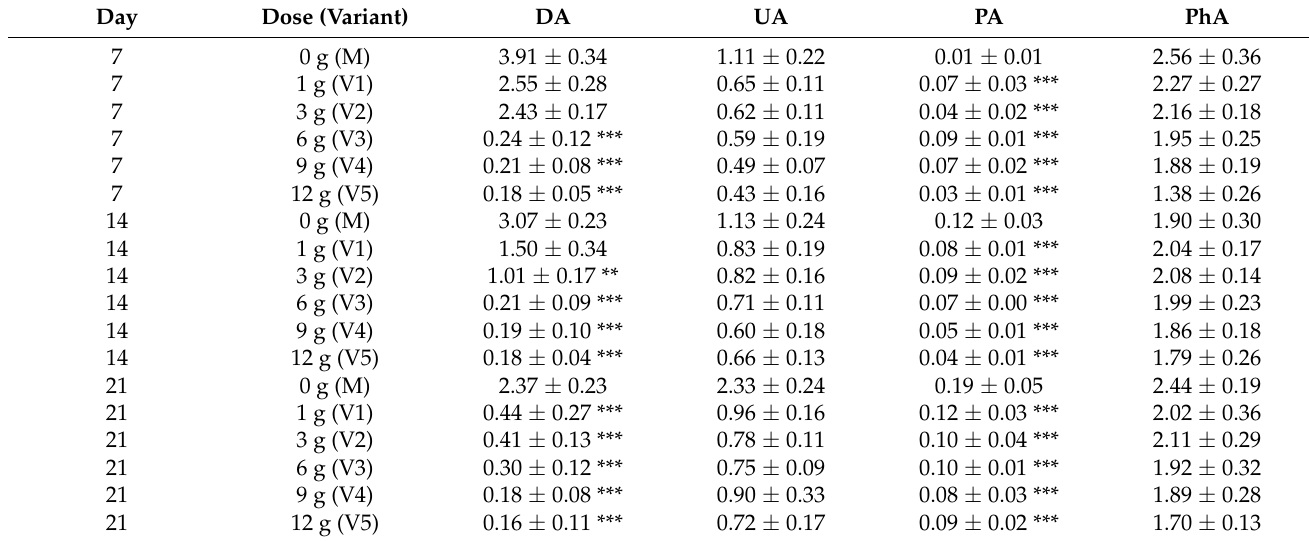
Table 2. The mean levels for dehydrogenase (DA), urease (UA), protease (PA) and phosphatase (PhA) activity for every experimental variant at each time point. The meaning of the experimental variants (M, V1–V5) is specified in Table 1. Day